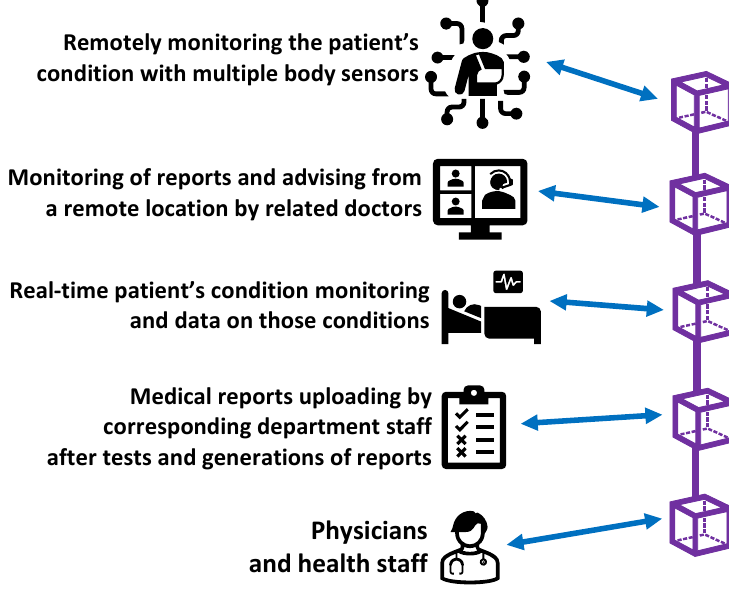
Figure 2. The proposed IoMT architecture with the use of Blockchain technology.